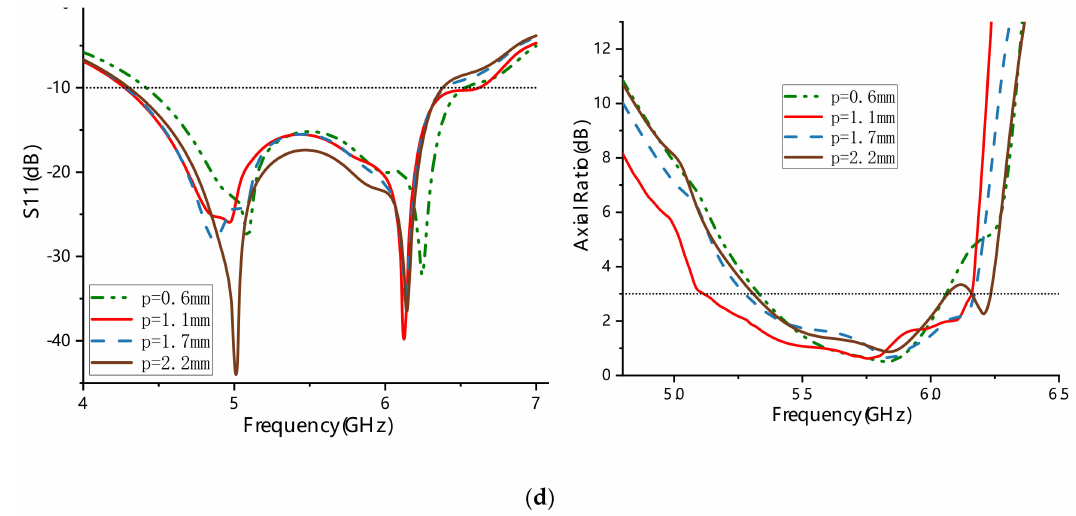
Figure 6. Axial ratio (AR) and S 11 characteristics of the proposed metasurface antenna with di ff erent parameters: ( a ) a; ( b ) w; ( c ) h 1 ; ( d ) p.